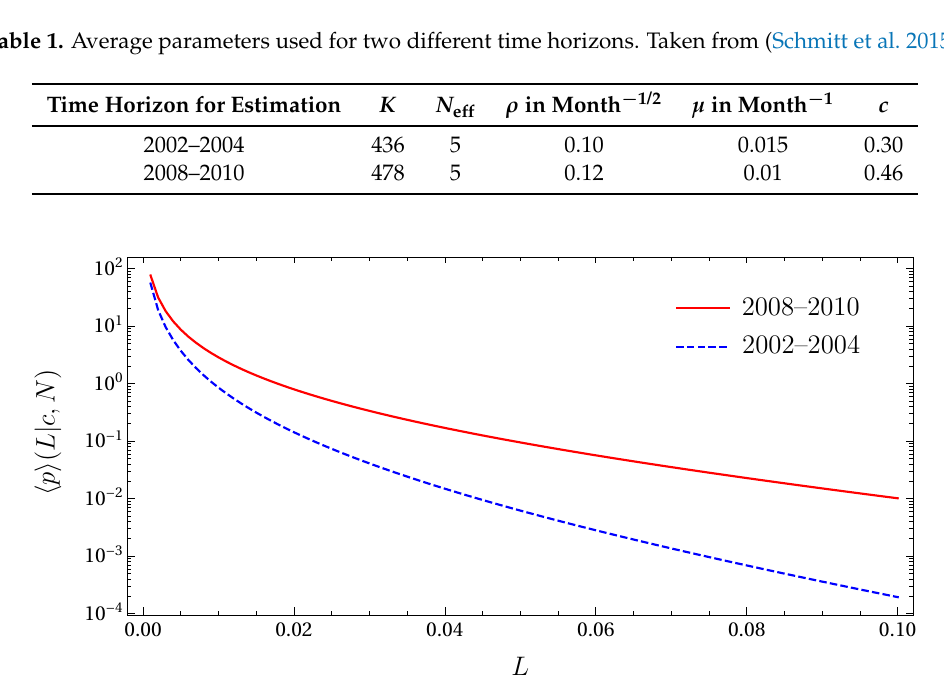
Figure 8. Average loss distribution for different parameters taken from Table 1. The dashed line corresponds to the calm period 2002–2004; the solid line corresponds to the global financial crisis